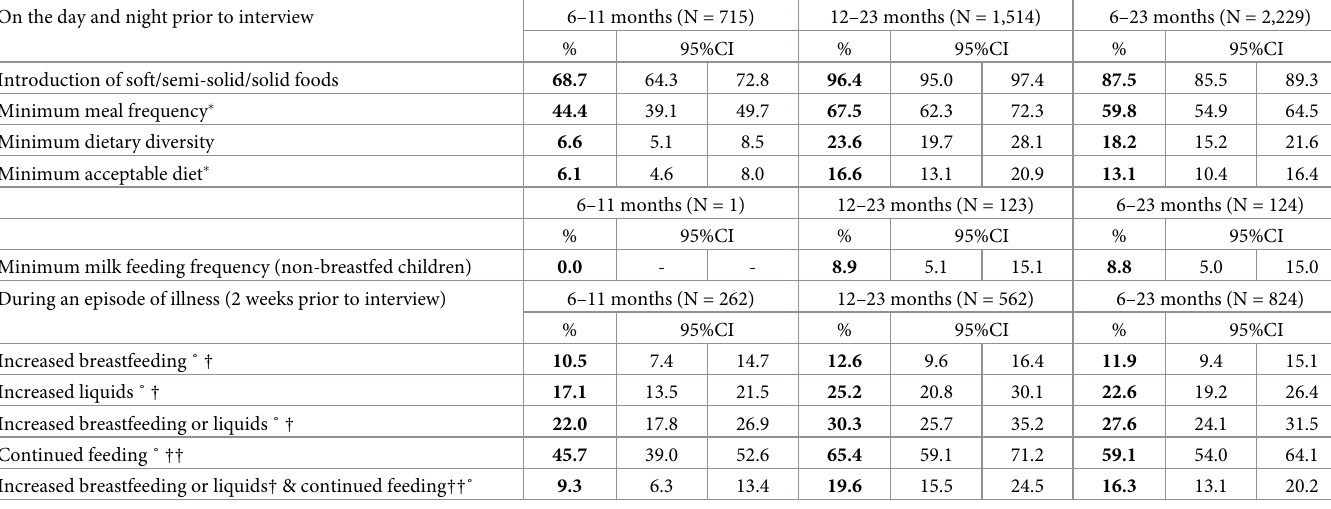
Table 1. IYCF practices indicators as per WHO guidelines per age group (6–11 and 12–23 months) and